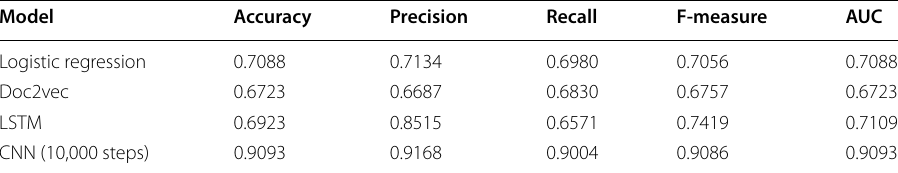
Table 8 Compare Deep Learning models in financial sentiment analysis